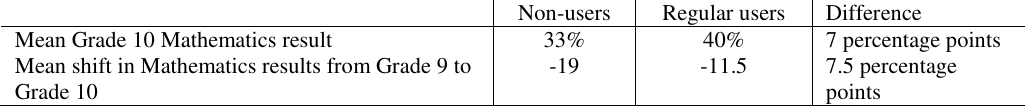
Table 4 Shifts in mean results